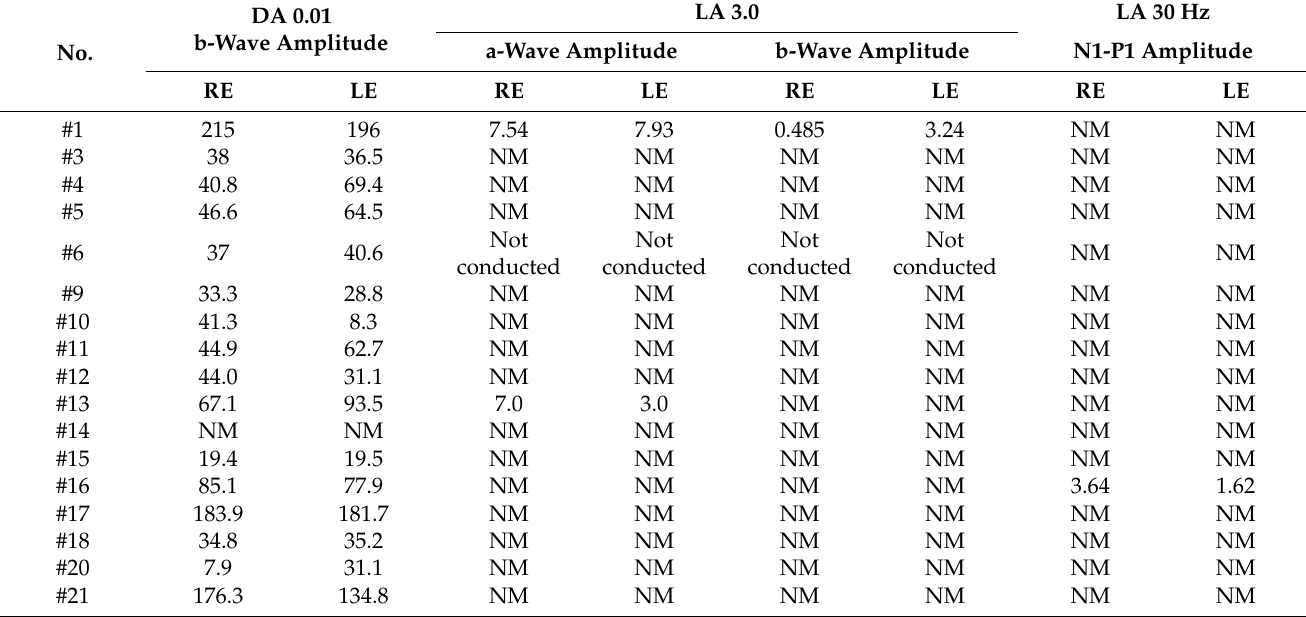
Table 2. Electroretinogram data.